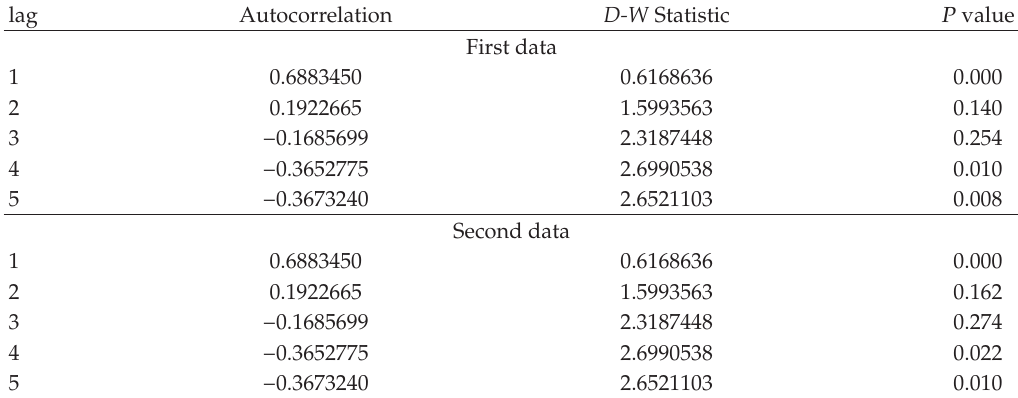
Table 2: Summary for Durbin-Watson